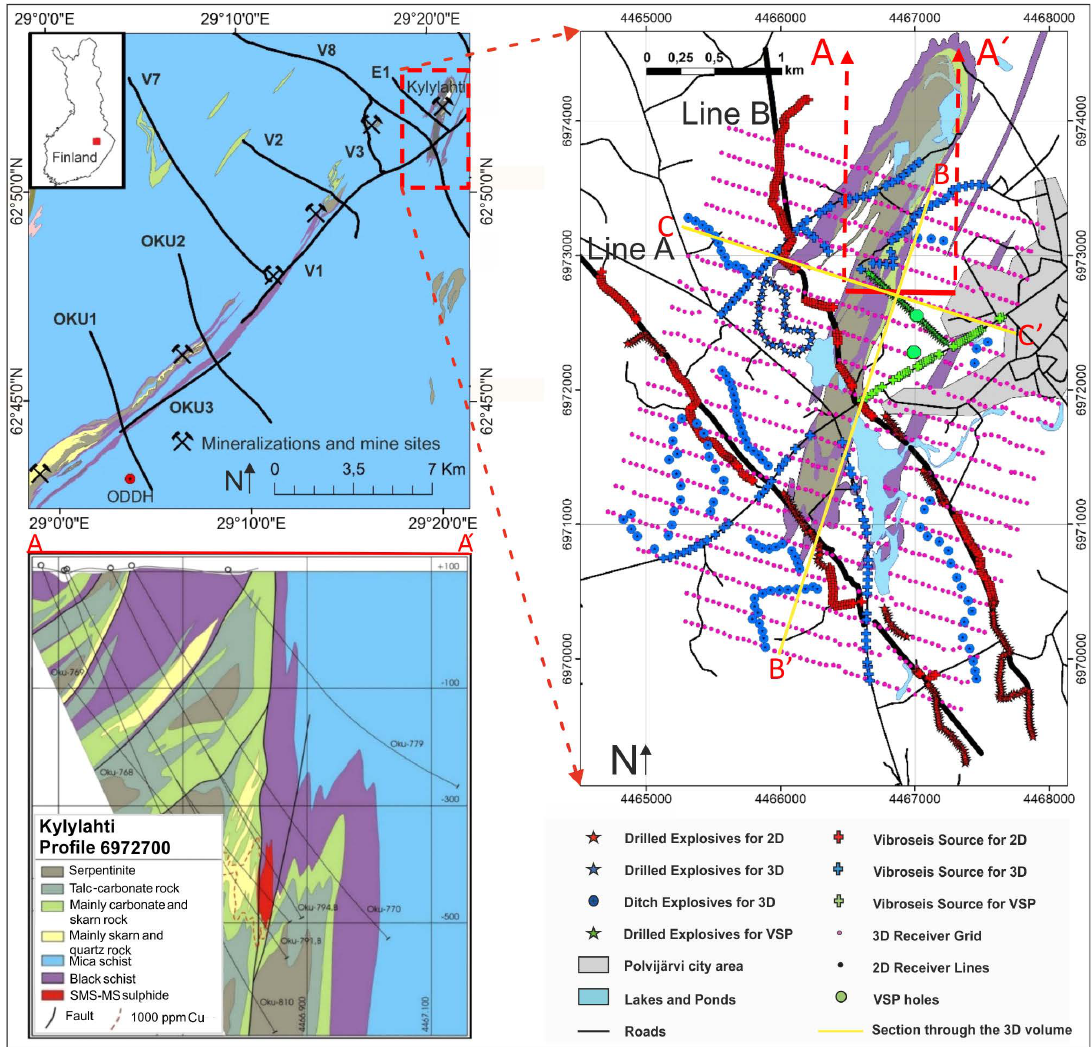
Figure 1. Location of the Kylylahti mine in the Outukumpu belt (top left) (Figure from “Bedrock of Finland—DigiKPDigitalMapDatabase”; pleaseseereferenceforfulldescription[25]). Acquisitiongeometry of the COGITO-MIN 3D seismic survey (right panel). A-A’ is a cross-section through the Kylylahti deposit (bottom left) [26]. Yellow lines B-B’ and C-C’ mark a representative crossline and inline location, respectively, of the 3D seismic volume. This crossline and inline are used to showcase the imaging results. Labels show 2D profiles acquired within the same project (Line A and Line